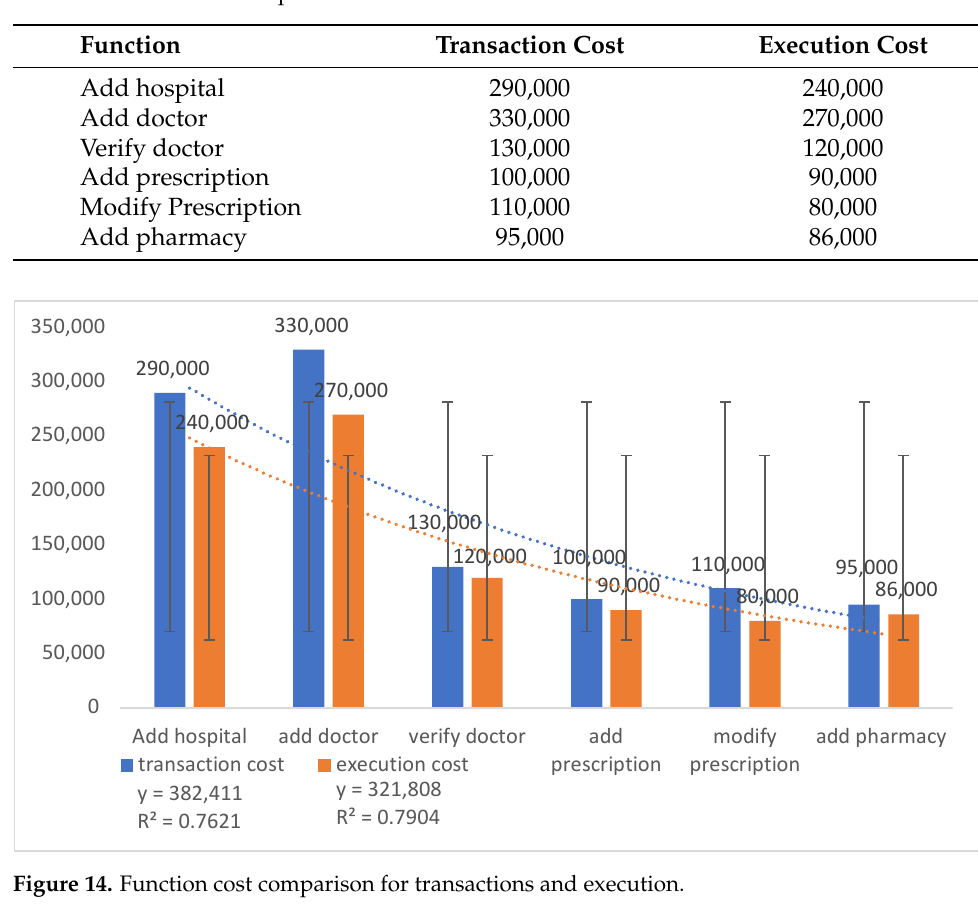
Table 6. Function cost comparison for transactions and execution.